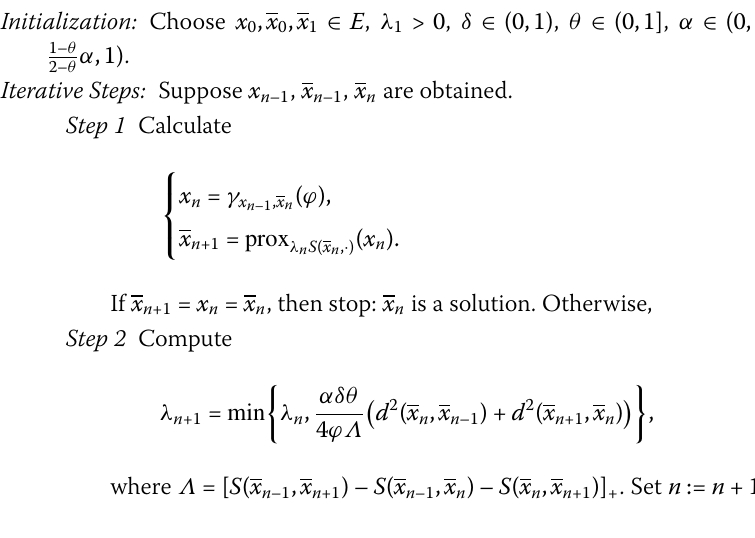
Algorithm 3.1 (Extragradient-like algorithm for solving